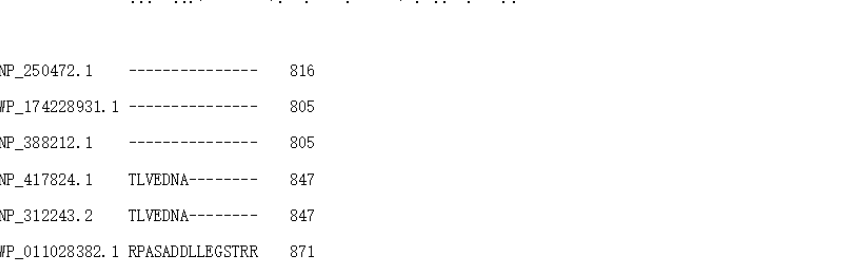
Figure 4. Multiple sequence alignment of NiRs from different strains. Uncharacterized conserved domains are marked with orange boxes, [Fe-S] domains are marked with black boxes, the possible NADH binding sites are marked with red dashed boxes, and the consensus hydrophobic regions are marked by green boxes. ‘*’ indicates positions which have a single, fully conserved